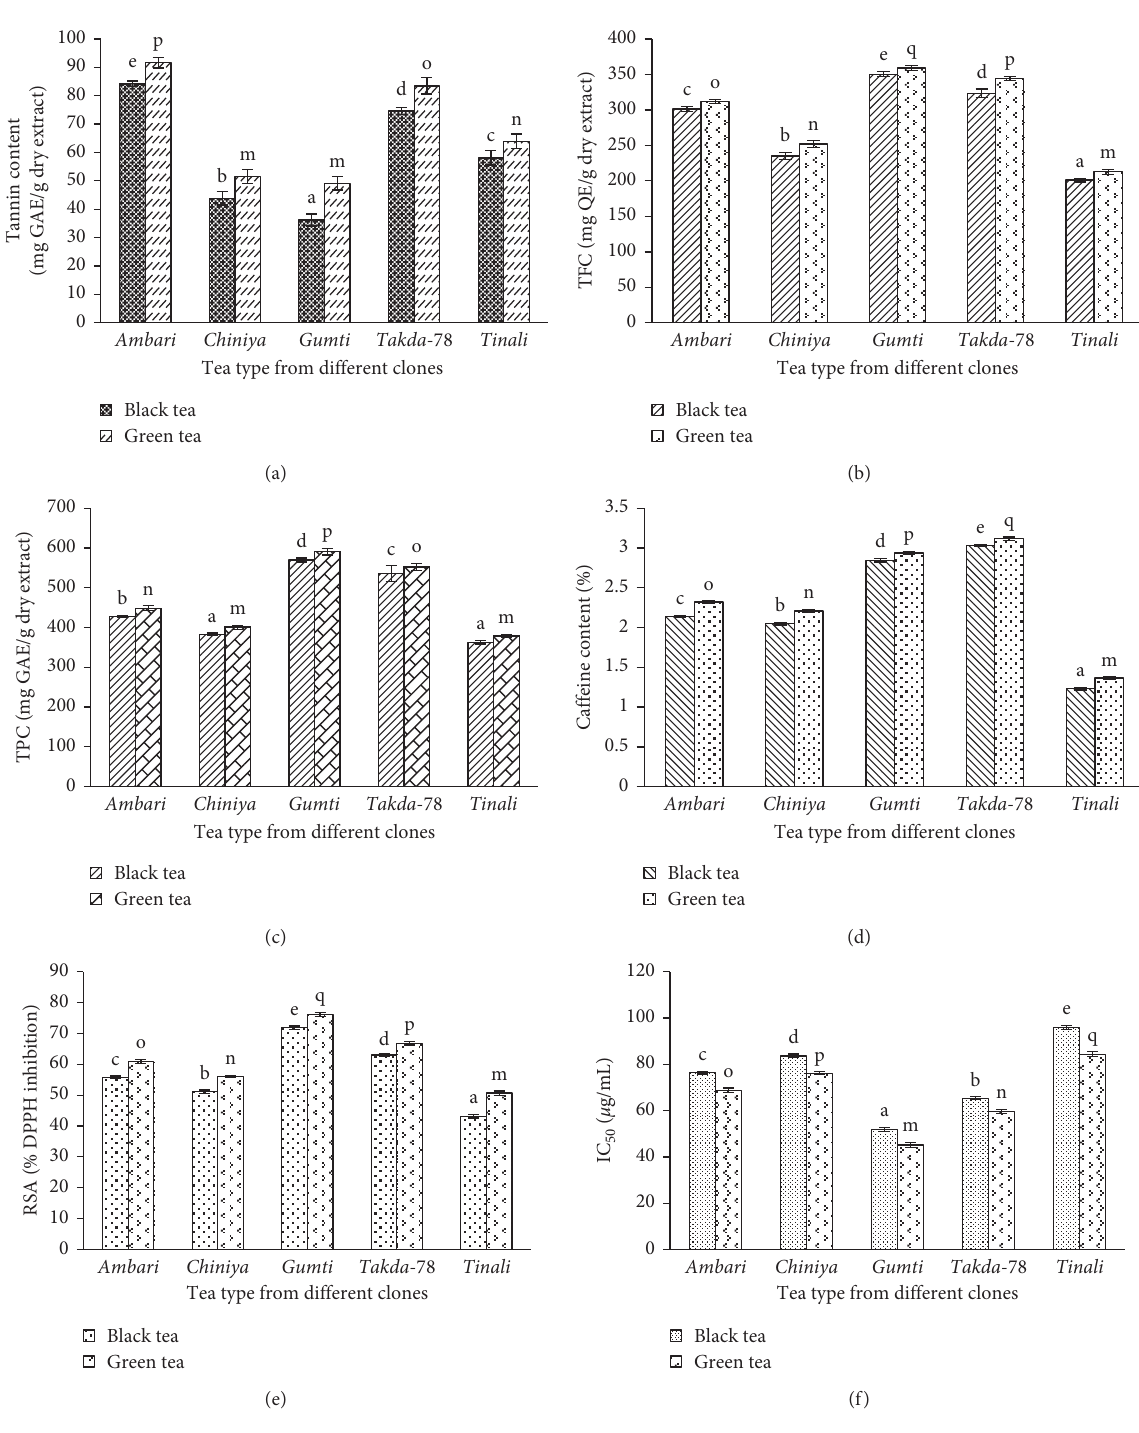
Figure 4: Phytochemicals and antioxidant activity of tea types from different clones: (a) tannin content, (b) total flavonoid content, (c) total phenol content, (d) caffeine content, (e) RSA (% DPPH inhibition), and (f) IC50. Error bars show standard deviation and error bars bearing different superscripts are different ( p < 0 . 05) with one-way ANOVA, and QE, GAE, and RSA refer to quercetin equivalent, gallic acid equivalent, and radical scavenging activity,